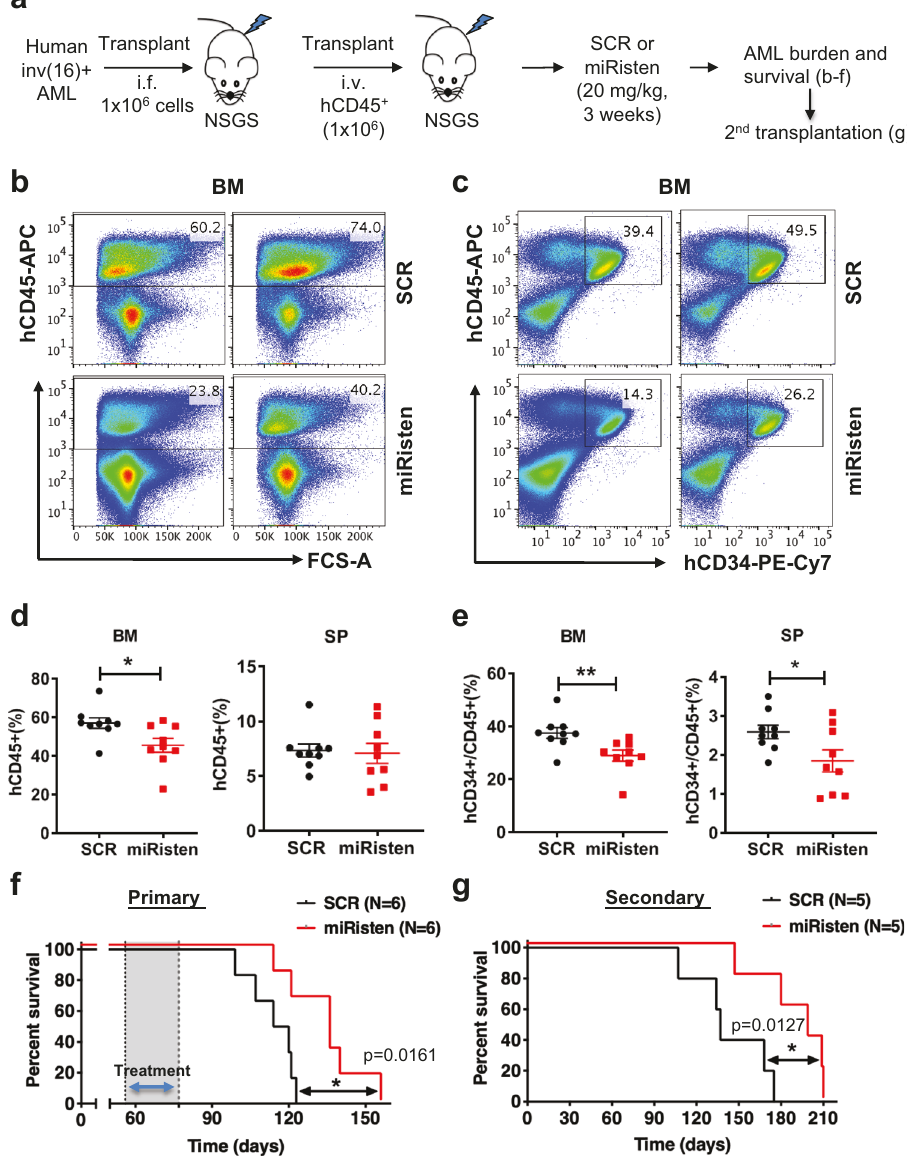
Fig. 7 Administration of miRisten effectively inhibits AML propagation and leukemia-initiating activity in inv(16) AML PDX model. a Schematic of experimental design. Inv(16) AML PDX was established by directly injecting T cell-depleted primary AML cells (1 × 10 6 cells/mouse) i.f. into irradiated NSGS and subsequently expanded into larger cohorts by secondary transplantation via i.v. injection. After 8 weeks, PDX mice were treated with SCR control (20 mg/kg/dose, i.v., daily) or miRisten (20 mg/kg/dose, i.v., daily) for 3 weeks and followed by assessment of human cell engraftment in BM and spleen. b Representative FACS plots showing gating strategy and frequency of hCD45 + cells in BM of mice treated with SCR control (top) or miRisten (bottom) for 3 weeks. c Representative FACS plots showing gating and frequency of hCD34 + /CD45 + cells in BM of mice treated with SCR (top) or miRisten (bottom) for 3 weeks. d Frequency of hCD45 + AML cells in SCR (black) vs. miRisten (red) treated mice ( n = 9/group) BM ( p = 0.0222) or spleen (SP). e Frequency of hCD34 + /CD45 + AML cells in SCR (black) vs. miRisten (red) treated mice ( n = 9/group) BM ( p = 0.01) or SP ( p = 0.0385). f The Kaplan – Meier survival curve of mice treated with SCR (black line; n = 6; median survival 117 days) or miRisten (red line; n = 6; median survival 136 days; p = 0.0161) for 3 weeks starting at 8 weeks after transplant. Dotted line with gray shade indicates treatment window. g The Kaplan – Meier survival curve of second transplant recipients treated with SCR (black line; n = 5; median survival 137 days) or miRisten (red line; n = 5; median survival 199 days; p = 0.0127). The statistical signi fi cance for f , g was determined using log-rank (Mantel – Cox) test. Each dot in d , e represents result from an individual mouse and data are presented as the mean ± SEM; statistical signi fi cance was determined using two-tailed Student ’ s T- tests (* p < 0.05; ** p < 0.01; *** p <